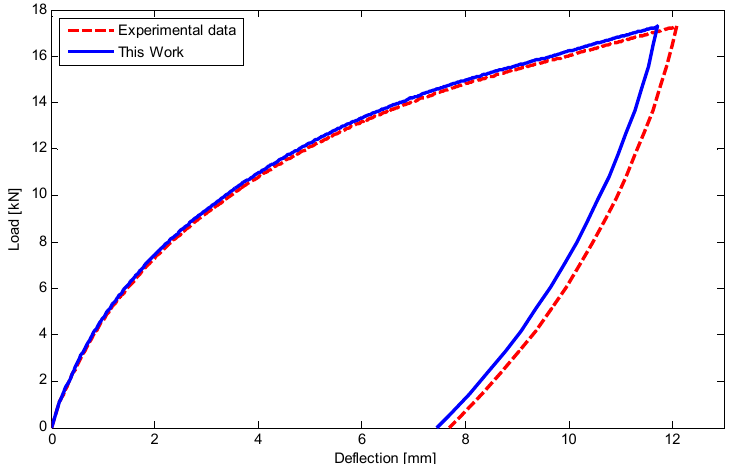
Figure 20. Comparison of load versus deflection for a circular SMA beam under four-point bending test with force of 17 kN at room temperature.